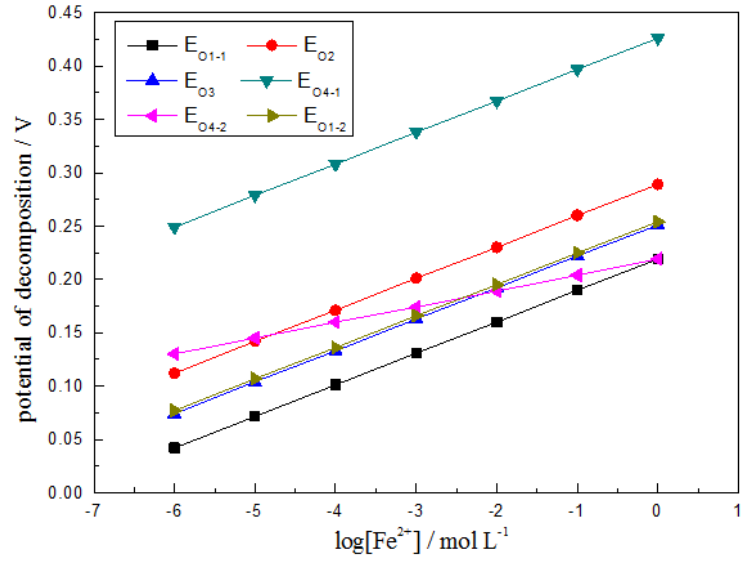
Figure 1. Relation between decomposition potential of chalcopyrite and routes.